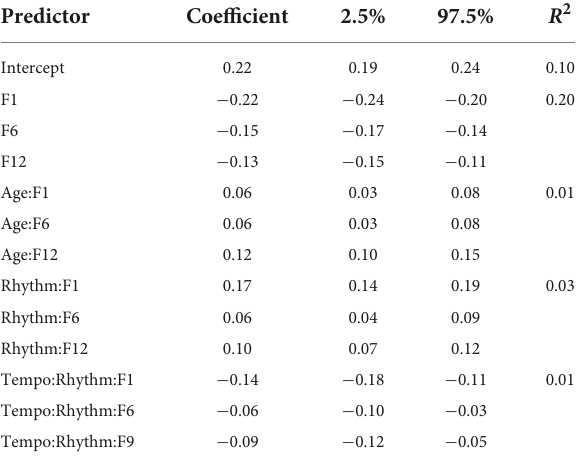
TABLE 3 Summary of significant predictors with R 2 > 0.01 from the maximally fitted multiple linear regression model predicting neural activity amplitude at meter-related frequencies, including coefficient, Wald 95% confidence intervals and R 2 for each predictor (where there are multiple levels, R 2 is given for the predictor as a